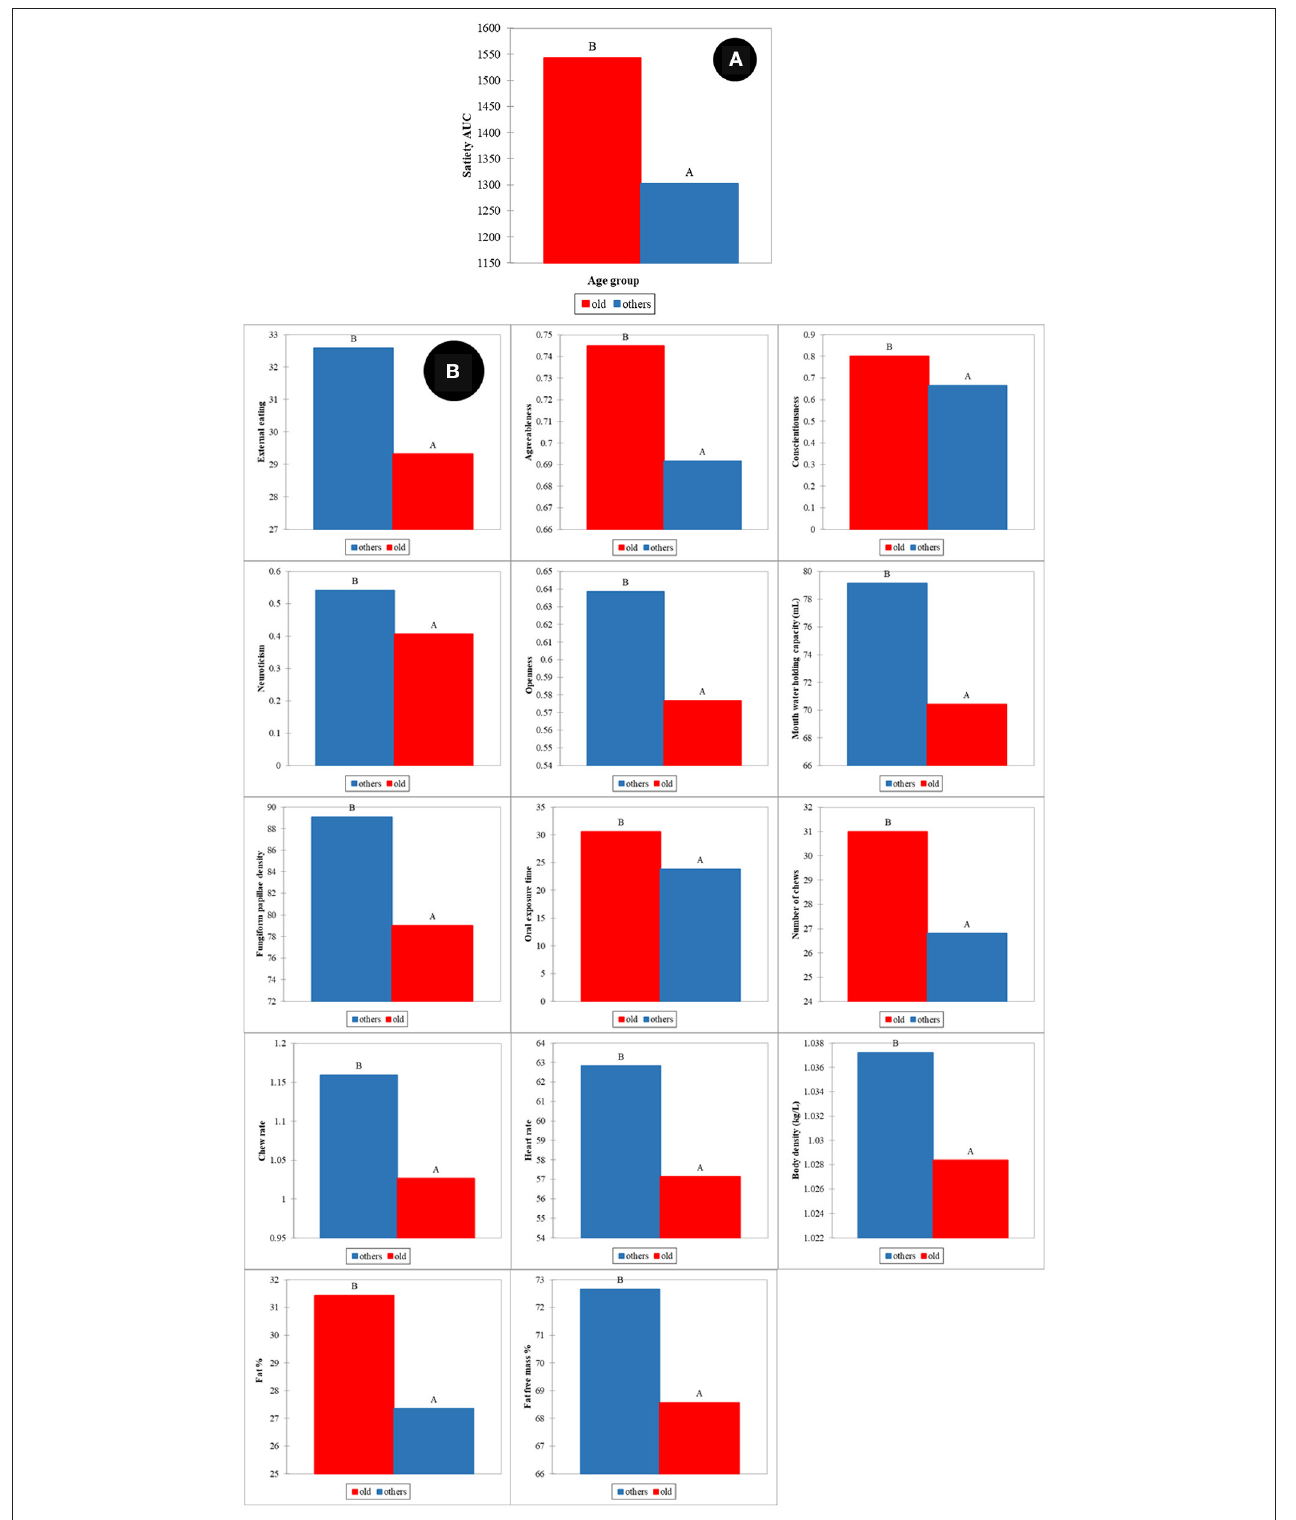
FIGURE 6 | Age effects on satiety (A) and human factors (B) . All mean differences between age groups are significant at the 0.05 level and labeled with different letters.